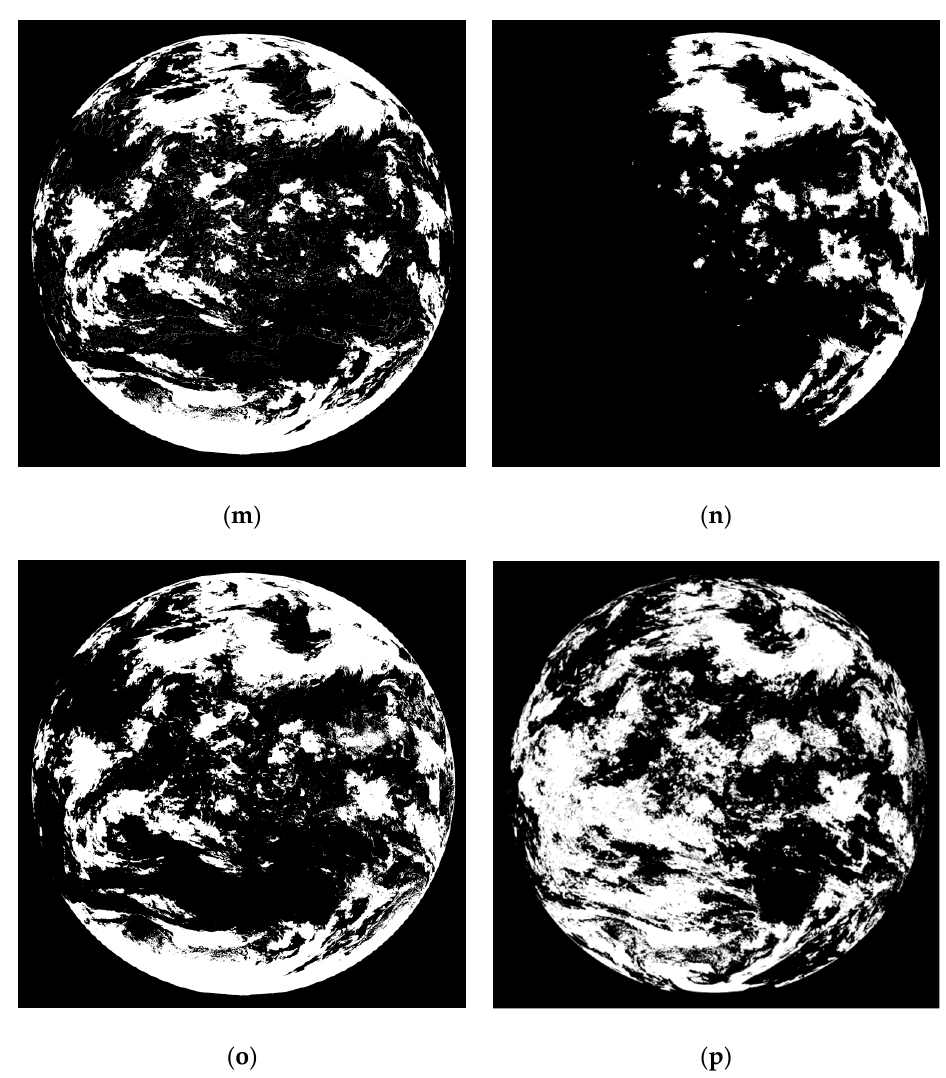
Figure 6. The results of ten threshold-based methods and the ensemble threshold result. ( a ) VIS image; ( b ) IR1 image; ( c ) Block OTSU method; ( d ) Local dynamic threshold method; ( e ) Global and local threshold combination method; ( f ) Wellner adaptive threshold; ( g ) Minimum error method; ( h ) OTSU method; ( i ) Bimodal method; ( j ) Iterative threshold method; ( k ) Maximum entropy threshold method; ( l ) Fixed threshold method; ( m ) IR1 ensemble threshold result; ( n ) VIS ensemble threshold result; ( o )